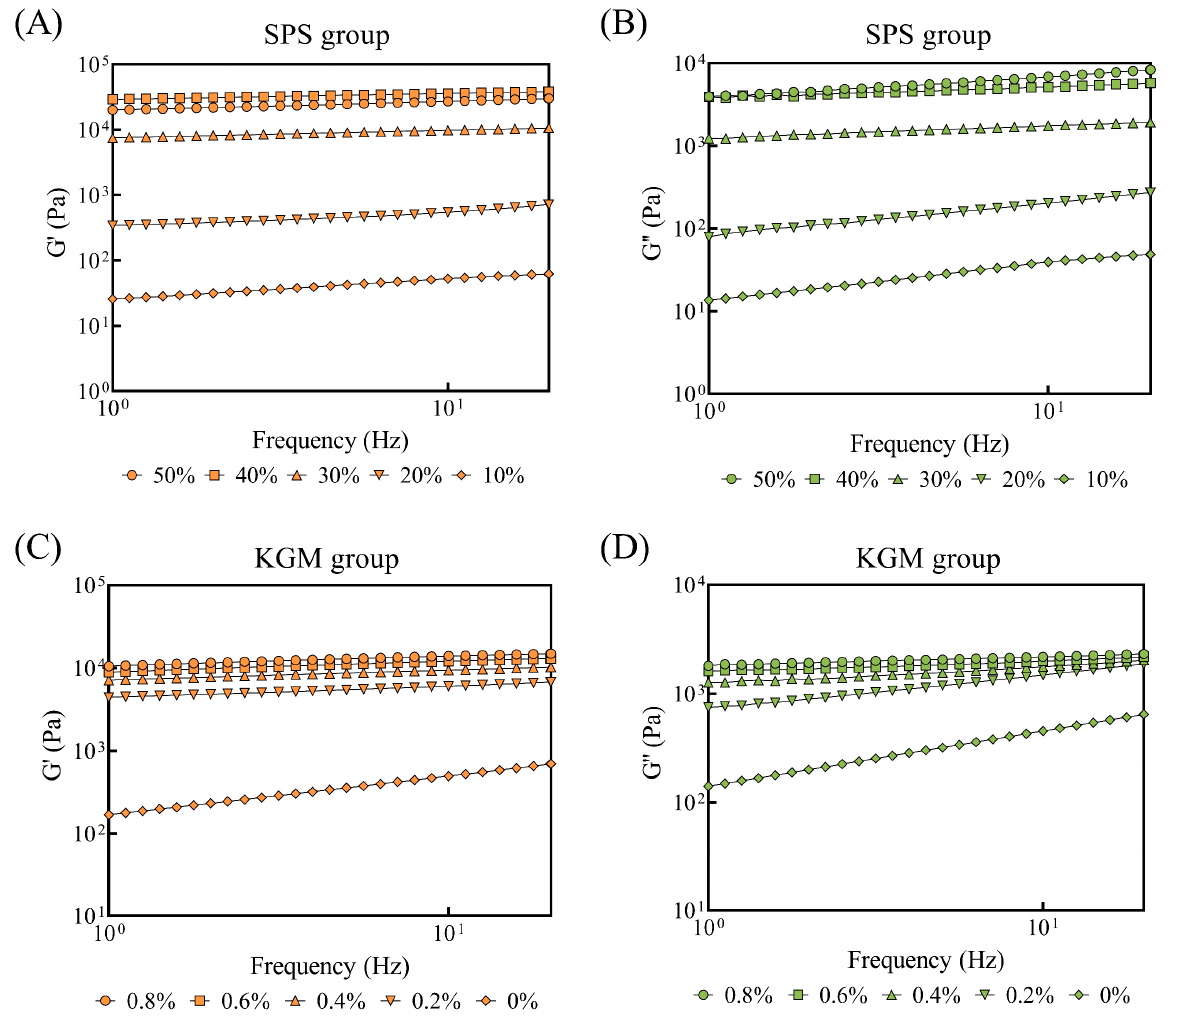
Figure 3. The G’ and G’’ of the plant-based pork rinds (frequency scanning) containing different SPS ( A , B ) and KGM ( C , D ) concentrations.